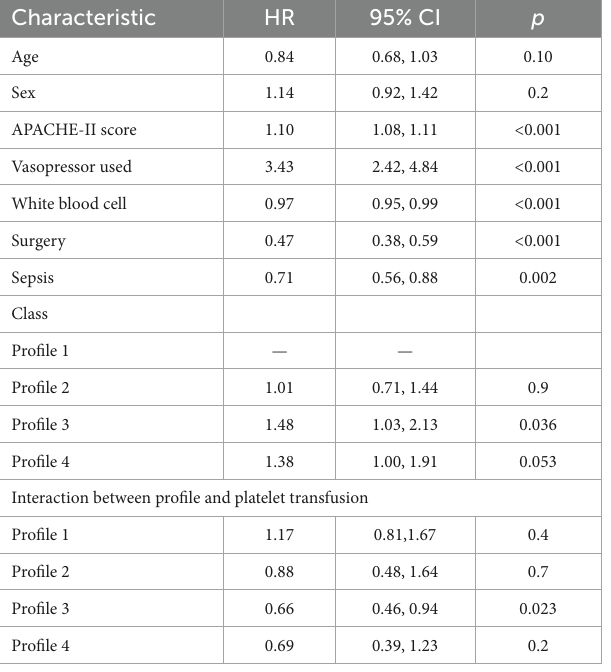
TABLE 3 Cox’s proportional hazard models for platelet transfusion and hospital mortality in different profiles.